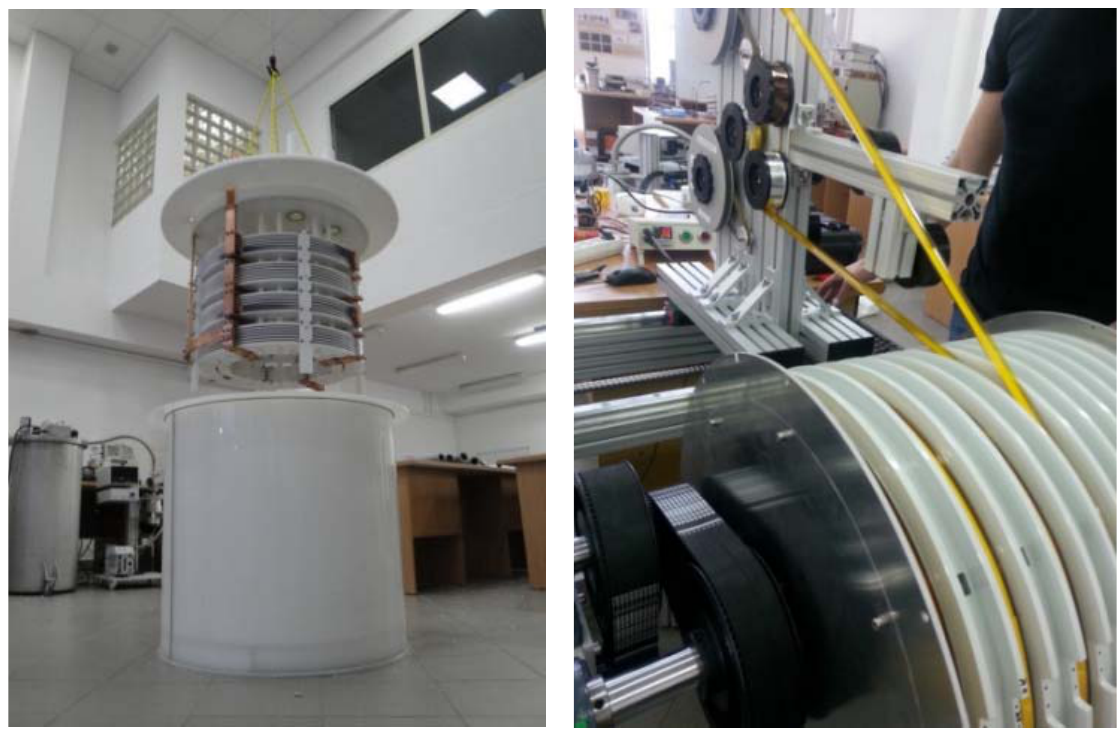
Figure 2. The first and second medium voltage SFCL [4,5,6,7,8,9].